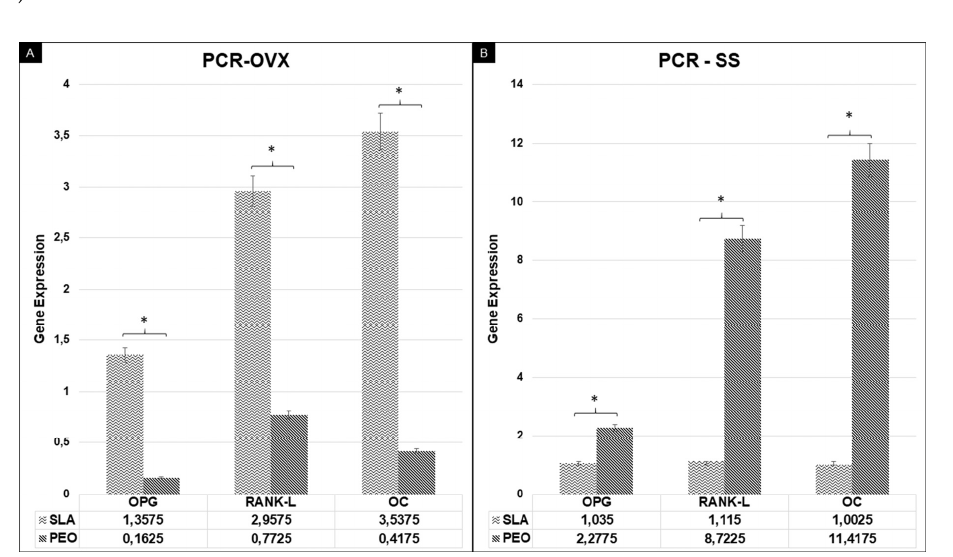
Figure 2. Relative gene expression of osteoprotegerin (OPG), receptor activator of nuclear kappa-B ligand (RANK-L), and osteocalcin (OC) ratio by real-time PCR analysis of the experimental groups. P < 0.05 denotes statistical significance differences (OVX/SLA × OVX/PEO) ( A ) and (SS/PEO × SS/SLA) ( B ) at 42 days. OVX: bilateral ovariectomy surgery group. SS: simulated surgery.